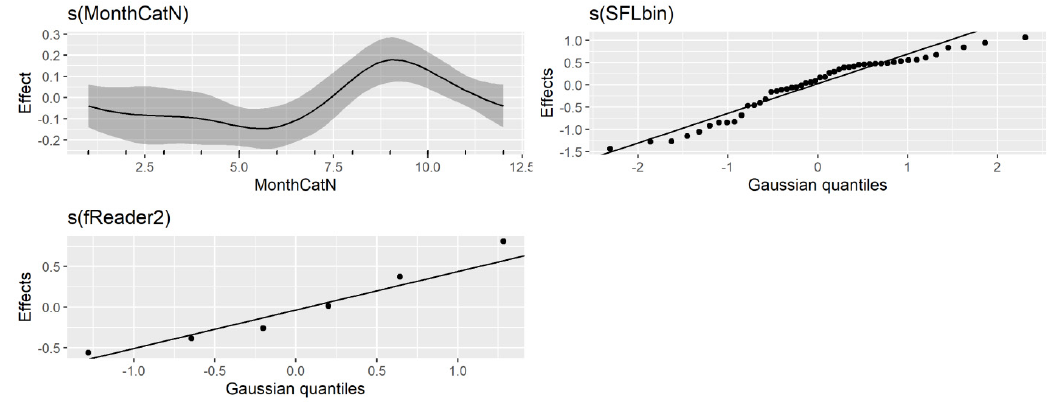
Figure 8. Diagnostic plots for the final GAM model. The QQ-plot and the histogram of the residuals are used to verify normality. The plot of standardized residuals against fitted values assesses homogeneity.